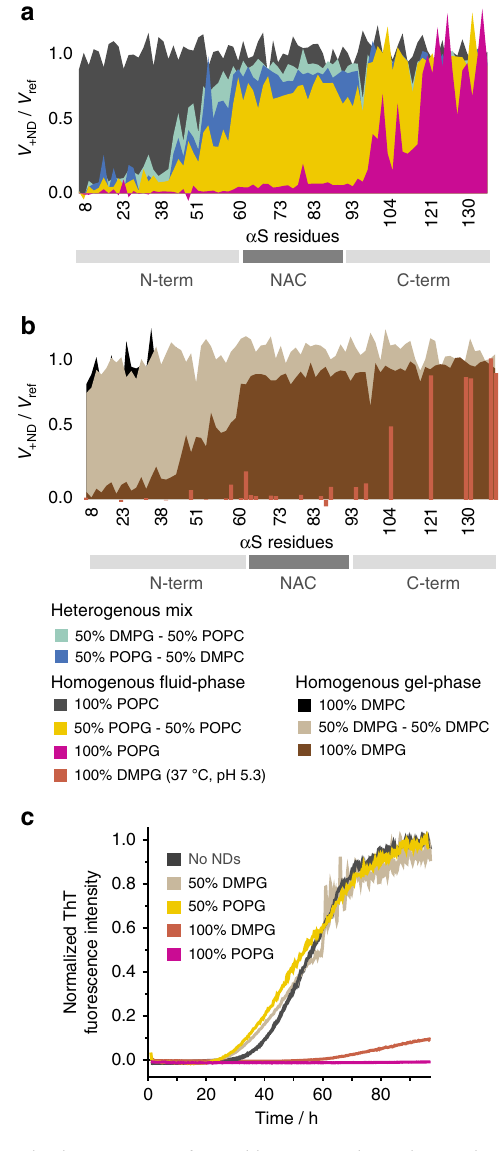
Fig. 3 α S – lipid interaction is favored by increased membrane plasticity. [ 15 N]- α S (50 µ M) NMR attenuation pro fi les in the presence of 25 µ M NDs with indicated lipid composition (molar ratio 2:1, α S-to-NDs) for bilayers that are in a more fl uid a or gel phase b at 10 °C. It is noteworthy that all NMR data are recorded at 10 °C and pH 7.4 with the exception of one of the 100% DMPG samples ( b , red bars) that was recorded at 37 °C and pH 5.3. c Corresponding ThT aggregation assays (50 µ M α S, 25 µ M NDs) for selected conditions (for better visibility only the mean values of triplicate measurements are shown, colors correspond to respective attenuation pro fi les in a , b heterogeneous mixtures DMPG/POPC and POPG/DMPC, and the homogeneous POPG/POPC mix behave very similarly (Fig. 3a), suggesting that the position of charge with respect to fatty acid as well as the ‘ surface roughness, ’ as potentially intro- duced by heterogeneous chain lengths, has little effect on α S – membrane interaction. Interestingly, a mixture of fully saturated lipids (dimyristoyl lipids) with 50% charge content does not considerably interact with α S (Fig. 3b, beige). At the temperature of the NMR experiments (10 °C), the bilayer formed by saturated dimyris- toyl lipids, in contrast to the partially unsaturated PO-lipids, is in